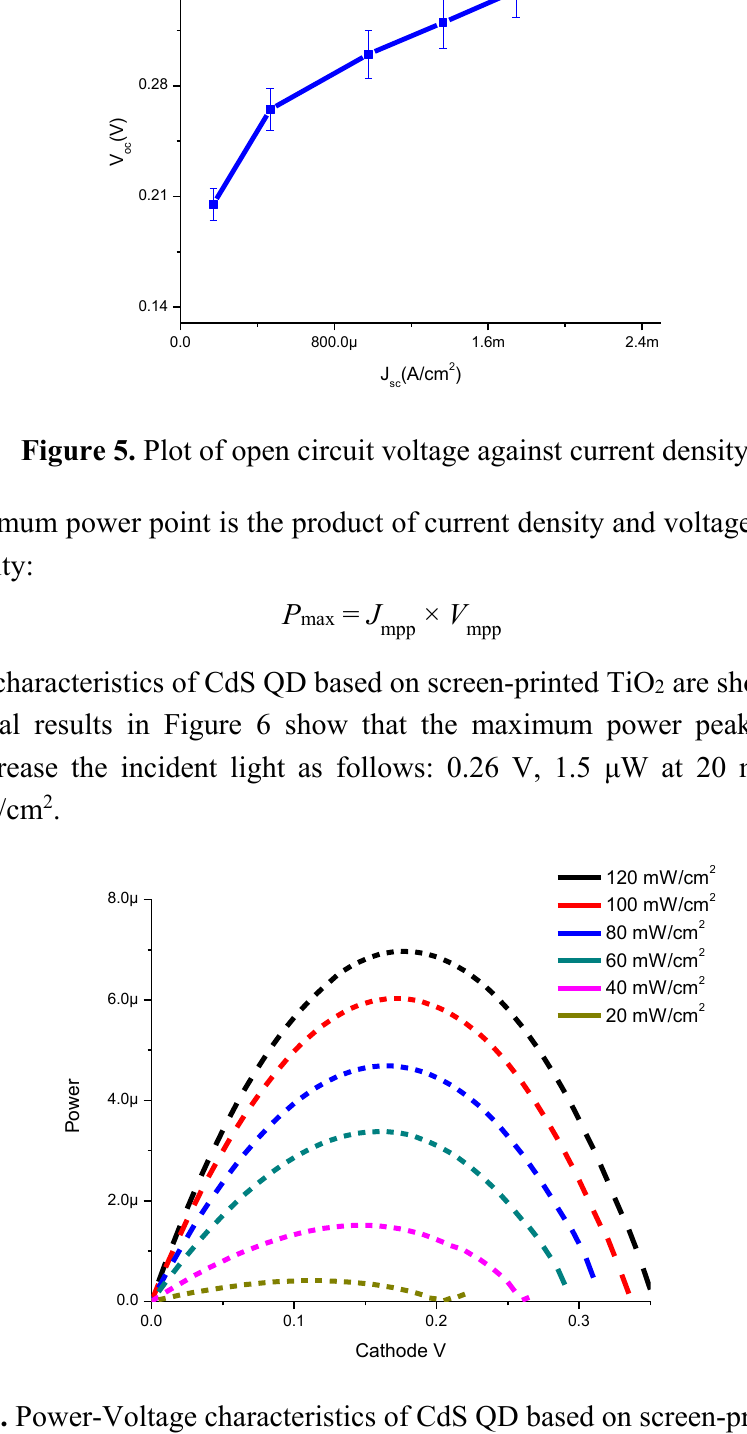
Figure 6. Power-Voltage characteristics of CdS QD based on screen-printed TiO 2